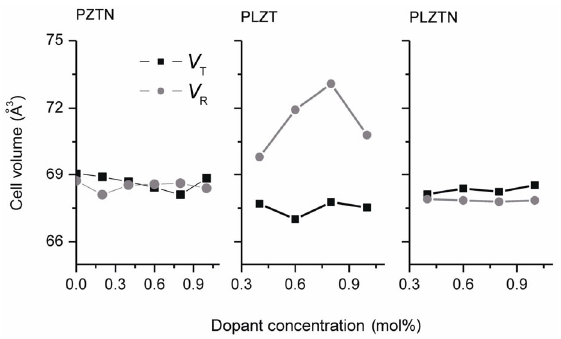
Fig. 3 Crystallographic cell volume considering both crystalline structures present, V T (tetragonal volume) and V R (rhombohedral volume) for analyzed